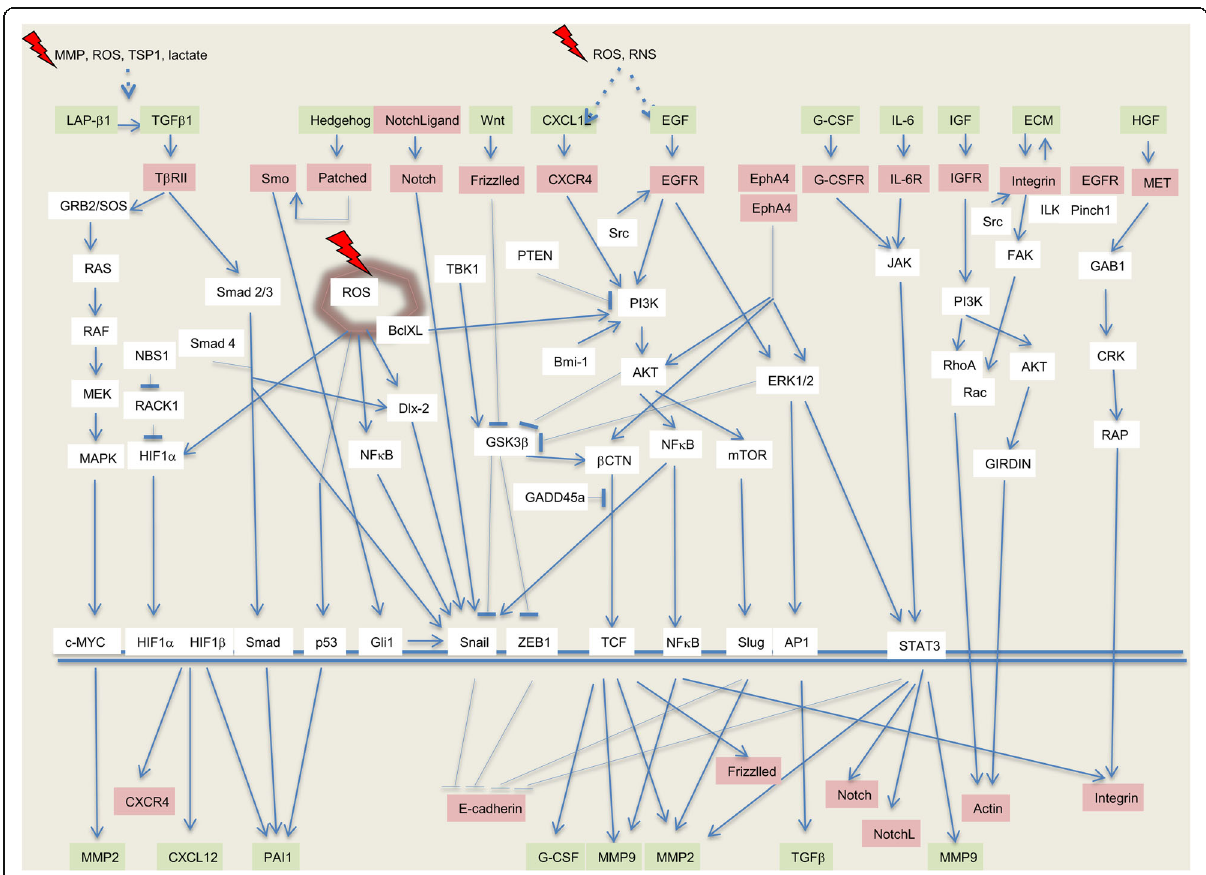
Fig. 1 Molecular pathways regulating cellular activities implicated in radiation -enhanced invasion and metastasis. Modified after Zhai et al., (2006b), Chargari et al., (2013), He et al., (2015b) and Lee et al., (2017b), with data from: Ahmed et al., (2013b); Asuthkar et al., (2011); Bastos et al., (2014); Chang et al., 2013b; Cheng et al., (2006b); Cho et al., (2016b); Cui et al., (2015b); de Marcondes (2017); Dong et al., (2015b); Eke & Cordes, (2015b); Fujita et al., (2014b); Fujita et al., (2015c); Gu et al., (2015b); He et al., (2015b); Ho et al., (2010b); Kang et al., (2013); Yan et al., (2013b); Kim et al., (2016); Kuo et al., (2015b); Liu et al., (2014b); Park et al., (2006b); Pichard et al., (2011b); Rajput et al., (2015b); Yuan et al., (2015b); Zhai et al., (2006b); Zhou et al., (2011b). Green, red and white boxes are secretory, transmembrane receptor and intracellular signaling molecules respectively. The glowing box is a mitochondrion; the double line is DNA. Abbreviations: Akt, protein kinase B; AP1, activator protein 1; BclxL, B-cell lymphoma-extra large; Bmi-1, B cell- specific Moloney murine leukemia virus integration site 1; β -CTN, beta-catenin; CRK, CT10 regulator of kinase; CXCL12, C-X-C motif chemokine 12; CXCR4, C-X-C chemokine receptor type 4; Dlx-2, distal-less homeobox-2; ECM, extracellular matrix; EGF, epidermal growth factor; EGFR, epidermal growth factor receptor; EphA4, ephrin A 4; ERK, extracellular signal-regulated kinase; FAK, focal adhesion kinase; GAB1, GRB2-associated-binding protein; GADD45a, Growth Arrest and DNA Damage inducible Alpha; GCSF, granulocyte colony stimulating factor; GCSFR, granulocyte colony stimulating factor receptor; GIRDIN, Guanine nucleotide-binding protein α subunit -interacting vesicle-associated protein; Gli1, Glioma-associated oncogen; GRB2, Growth factor receptor-bound protein 2; GSK3 β , glycogen synthase kinase 3 beta; HGF, hepatocyte growth factor; HIF-1, hypoxia-inducible factor-1; IGF, insulin- like growth factor; IGFR, insulin-like growth factor receptor; IL-6, interleukin 6; ILK, integrin-linked kinase; JAK, Janus kinase; LAP- β 1, latency-associated peptide of TGF- β ; MEK, mitogen-activated kinase kinase; MET, tyrosine-protein kinase Met; MMP, matrix metalloproteinase; mTOR, mechanistic target of rapamycin; NF- κ B, nuclear-factor kappa-light-chain-enhancer of activated B cell; Nrf2, Nuclear factor E2 related factor 2; NSB1, Nijmegen breakage syndrome 1; p53, Tumor protein p53; PAI-1, plasminogen activator inhibitor 1; PAK1, p21- activated kinase 1; PI3K, phosphatidylinositol 3-kinase; PTEN, phosphatase and tensin homolog; Rac, Ras-related C3 botulinum toxin substrate; RACK1, receptor for activated C kinase 1; RAF, Rapid Accelerated Fibrosarcoma; RAP, Ras-proximate; RAS, Rat sarcoma; RhoA, Ras homolog gene family member A; RNS, reactive nitrogen species; ROS, reactive oxygen species; Src, sarcoma family kinase; SMAD, small and mothers against decapentaplegic; Smo, Smoothened; SOS, Son of Sevenless; STAT, signal transducer and activator of transcription; TCF, T-cell factor; TGF- β , transforming growth factor beta; TKB-1, tank-binding kinase-1; TSP1, Trombospondin 1; T β RII, TGF- β type II receptor; Wnt, Wingless-related integration site; ZEP1, Zinc finger E-box-binding homeobo×